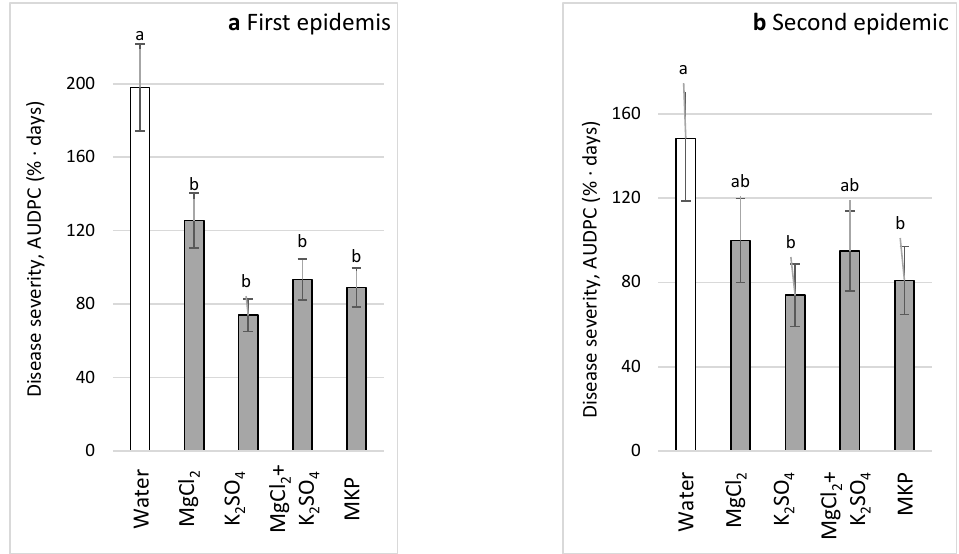
Figure 12. Effect of sprays every 3–6 days with MgCl 2 0.1 M (Cl), K 2 SO 4 0.1 M (SO 4 ), MgCl 2 + K 2 SO 4 , or monopotassium phosphate (MKP) on cucumber downy mildew (CDM, Pseudoperonospora cu- bensis ) under commercial-like conditions (CL2). CDM was followed during the first epidemic on lower leaves ( a ) and the second epidemic on upper leaves ( b ). CDM severity was evaluated on a 0